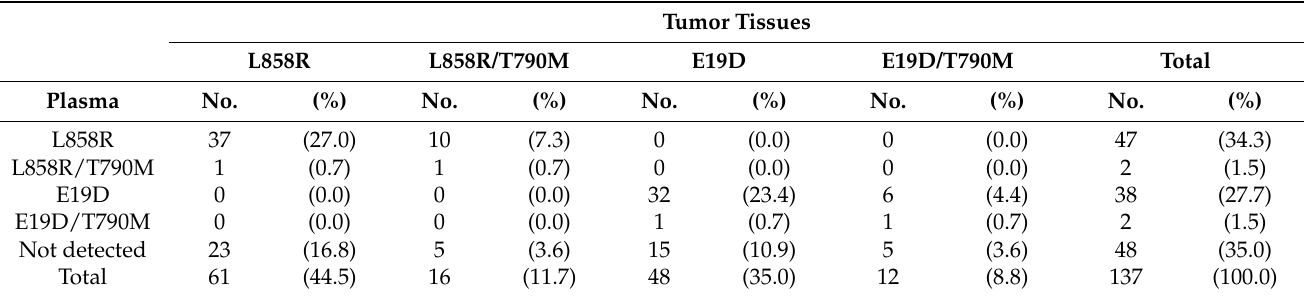
Table 2. Comparison of EGFR mutation status determined from baseline tumor tissues and plasma samples using the ddPCR platform (N = 137).